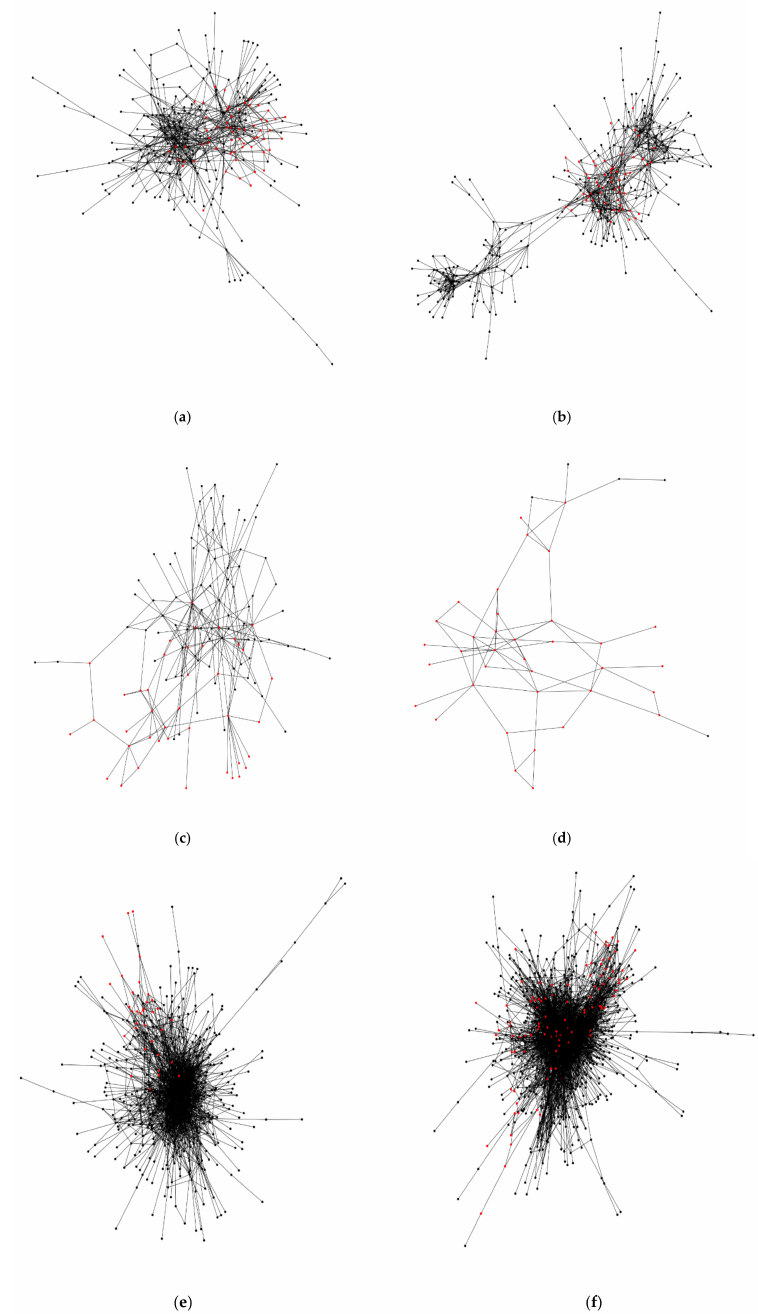
Figure 4. The major network component of each fruit fly brain region that contains more than one window with a putative square grid arrangement. The red color nodes indicate membership of neu- rons in a putative square grid arrangement, based on the data of the 46 subnetworks (Supplementary Materials; Section 3.2). The nodes in black color are neurons that are not members of a putative square grid. The edges are the synaptic connections. ( a ) Cantle region in the right hemisphere; ( b ) epaulette region in the left hemisphere; ( c ) flange region in the right hemisphere; ( d ) medulla region in the right hemisphere; ( e ) superior clamp region in the left hemisphere; ( f ) superior interme- diate protocerebrum in the left